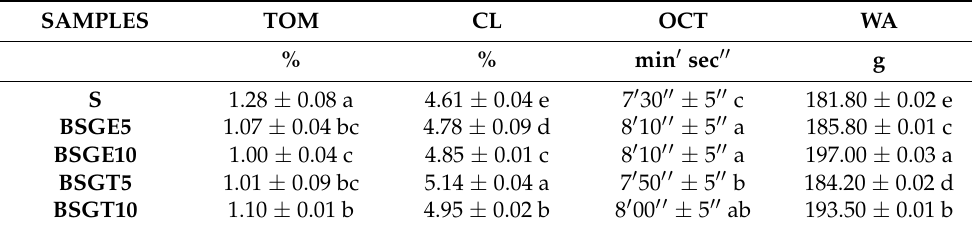
Table 3. Cooking properties of pasta with different blends of BSG/semolina. SAMPLES TOM CL OCT WA % % min (cid:48) sec